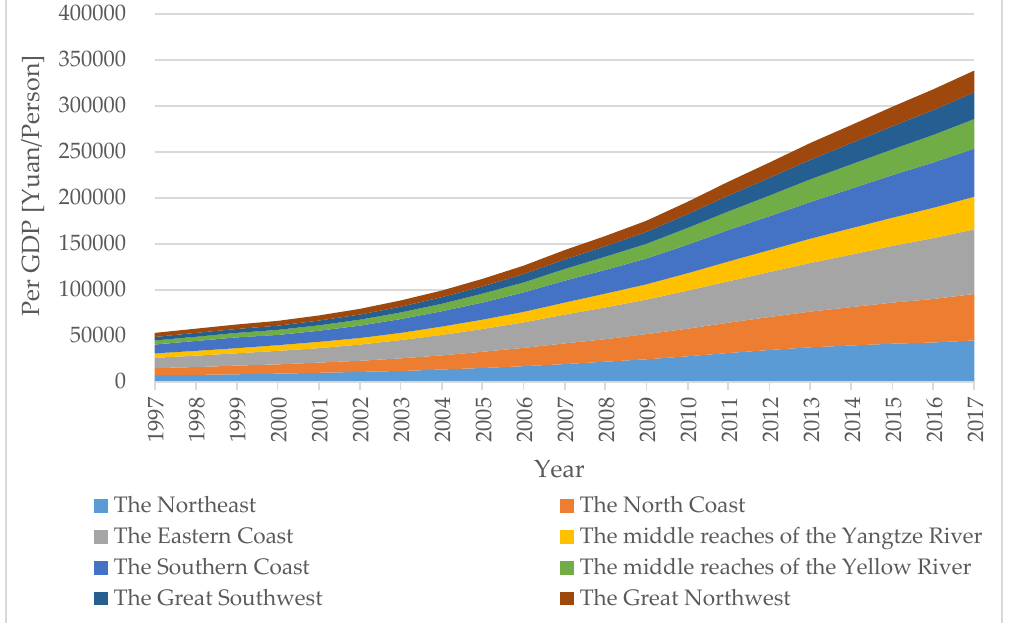
Figure 7. Regional population sizes of China from 1997 to 2017.